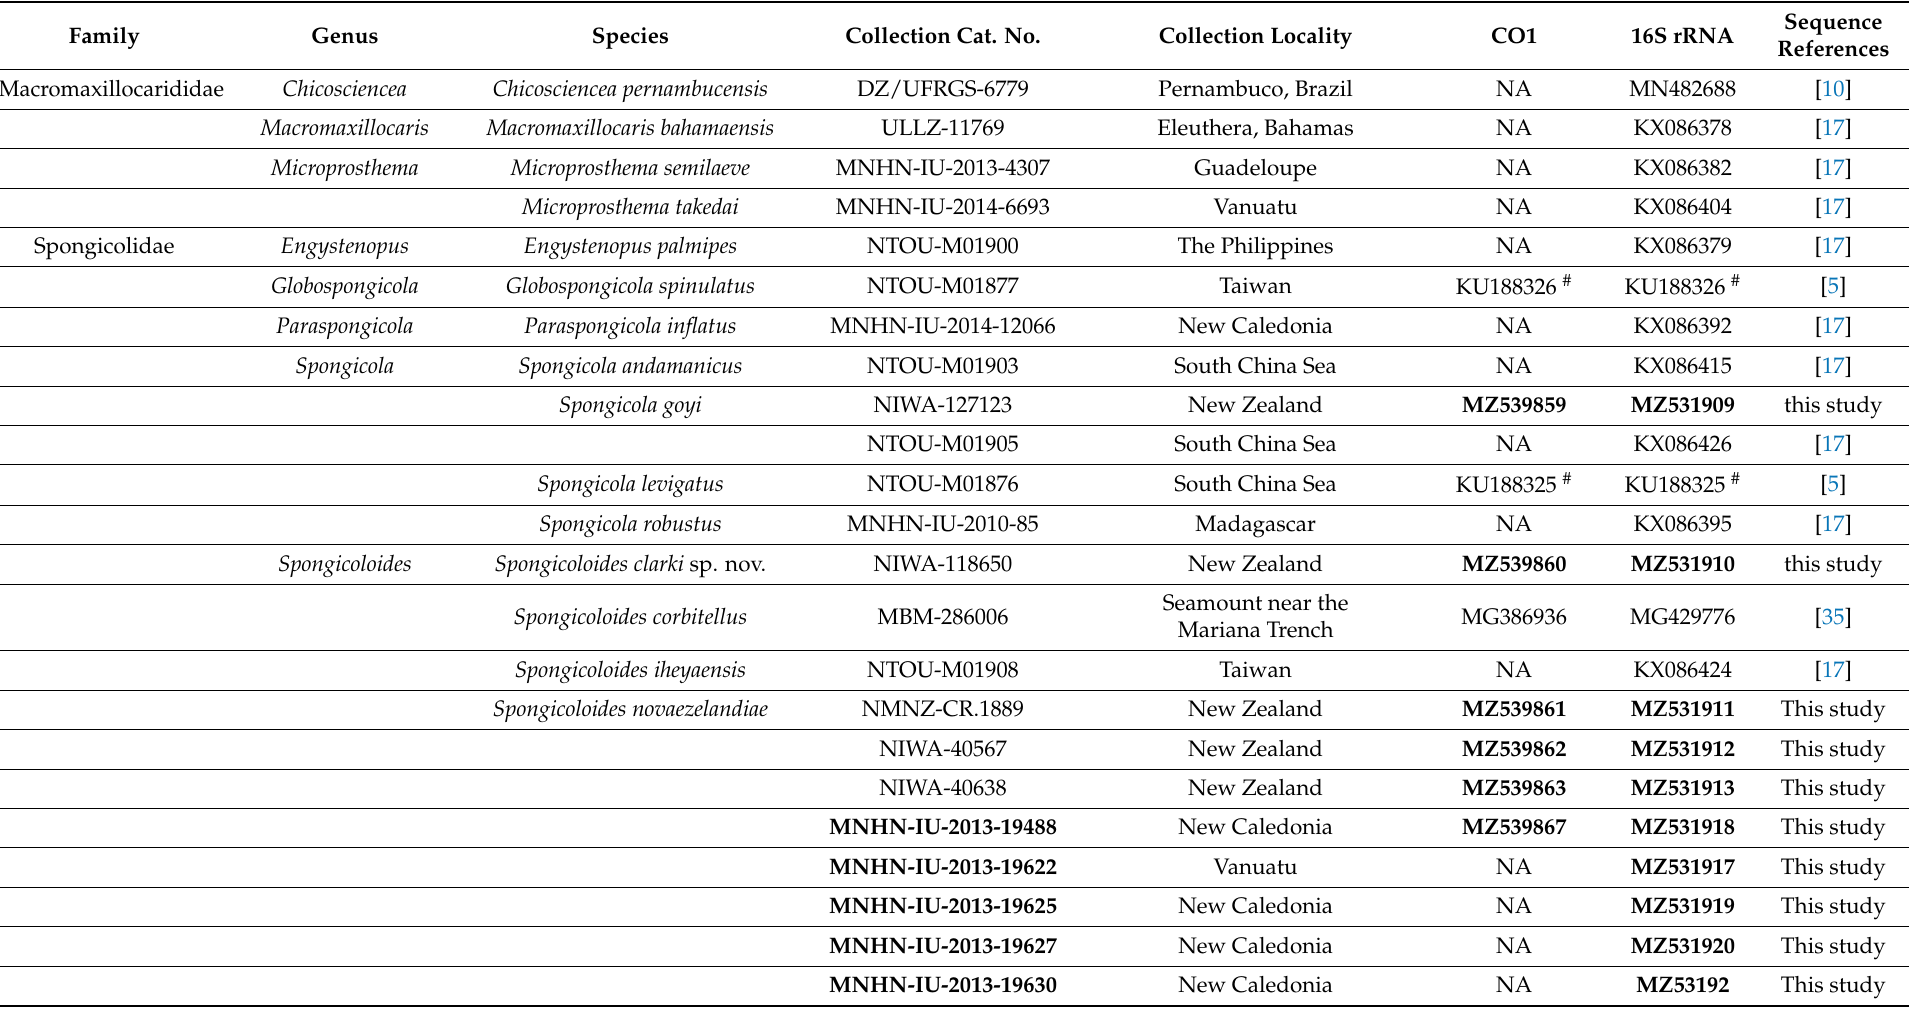
Table 1. List of all Stenopodidea sequences used in phylogenetic analyses, collection locality and their respective GenBank accession numbers. NA = not available. Collection catalogue numbers in bold indicate misidentified specimens. GenBank accession numbers in bold indicate new sequences presented in this